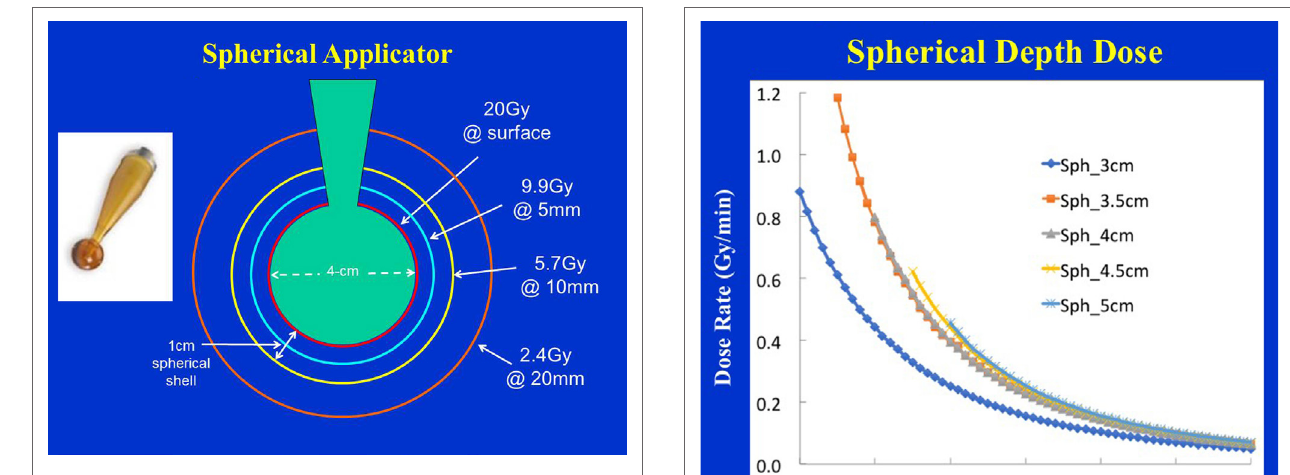
FigUre 4 | Dose distribution produced by a 4 cm diameter spherical applicator. Doses are shown at the applicator surface and at 5, 10, and 20 mm distance from it. Dose homogeneity was evaluated in a 1 cm thick spherical shell surrounding the applicator. Applicator shown in